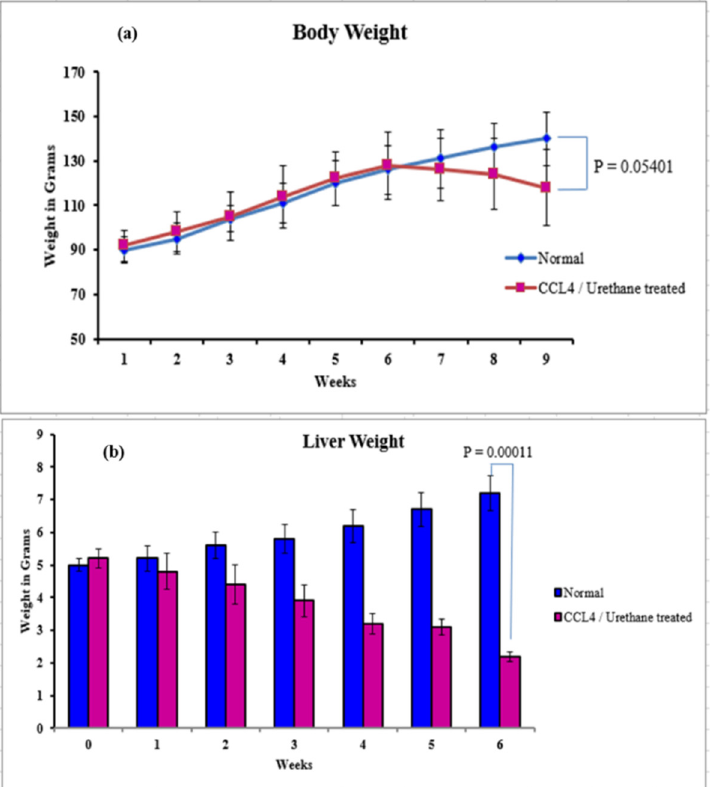
Figure 6. Weight analysis of normal versus CCL4/urethane treated rats from week one to week six. ( a ) Body ( b ) Liver . (Significance at p < 0.05). Table 1. Weekly comparison of Ascites of normal versus CCL4/urethane treated